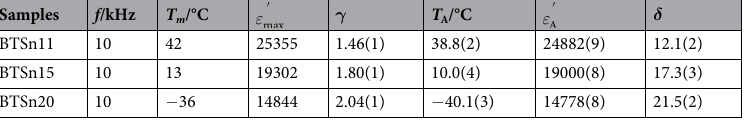
behavior. It is apparent in Fig. 2(d) that with an increase in Sn content, there is a systematic increase in γ in a fixed temperature range (as shown in the inset of Fig. 2(d)). Bokov et al . 25 recently proposed a Lorenz formula to describe the dependence of the dielectric permittivity on temperature at T > T m in relaxors,